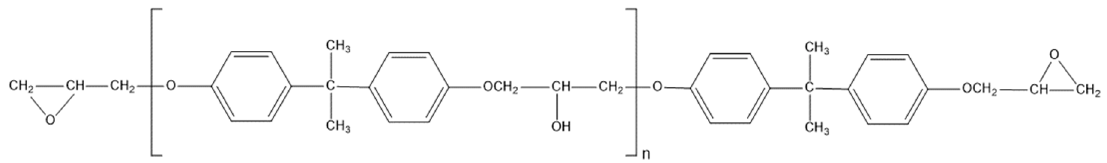
Figure 1. Chemical structure of bisphenol-A epoxy